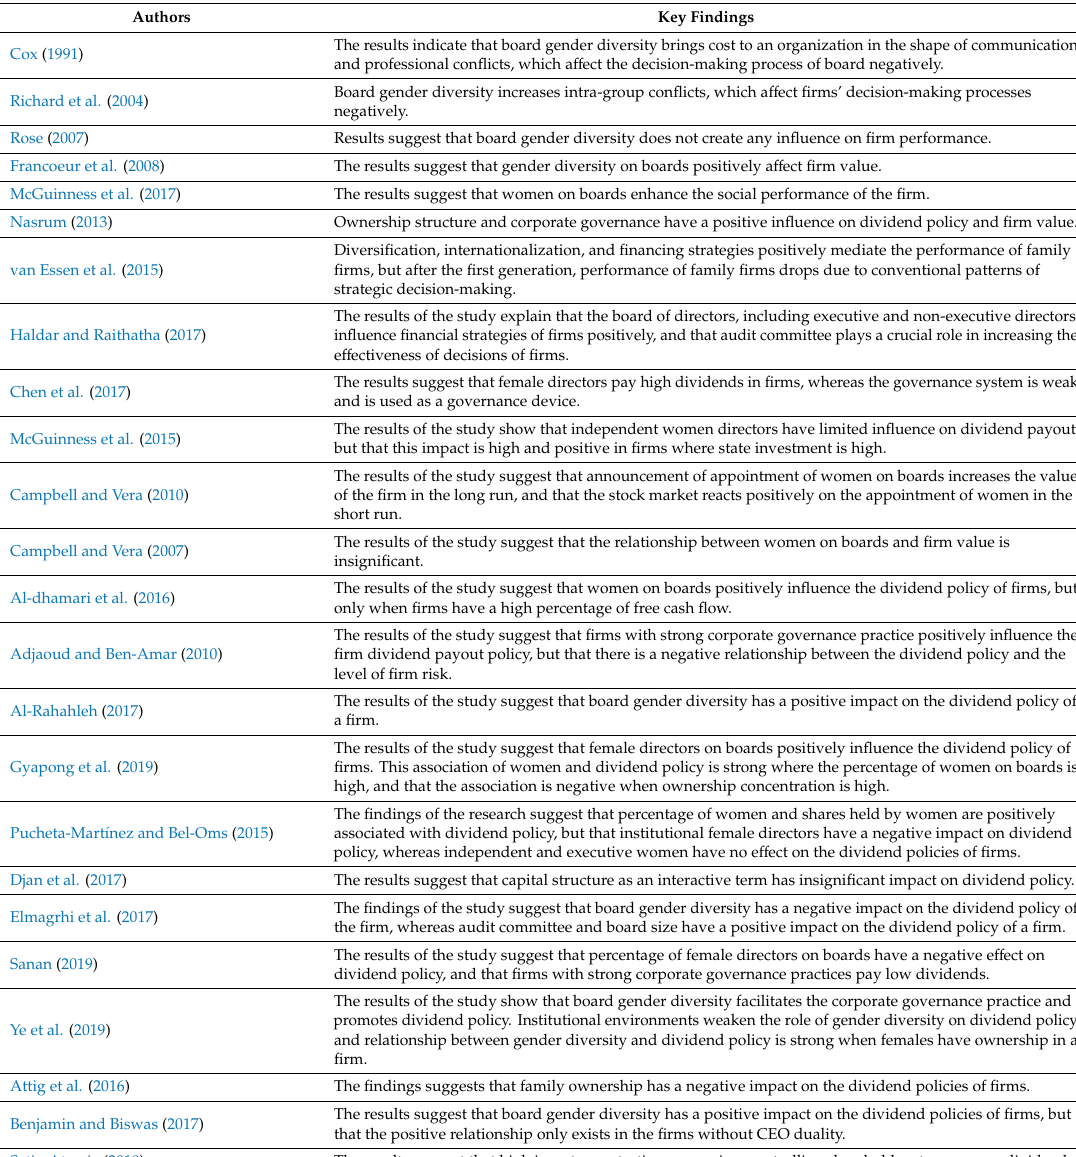
Table 1. Summary of studies on board gender diversity and its impact on firms’ financial